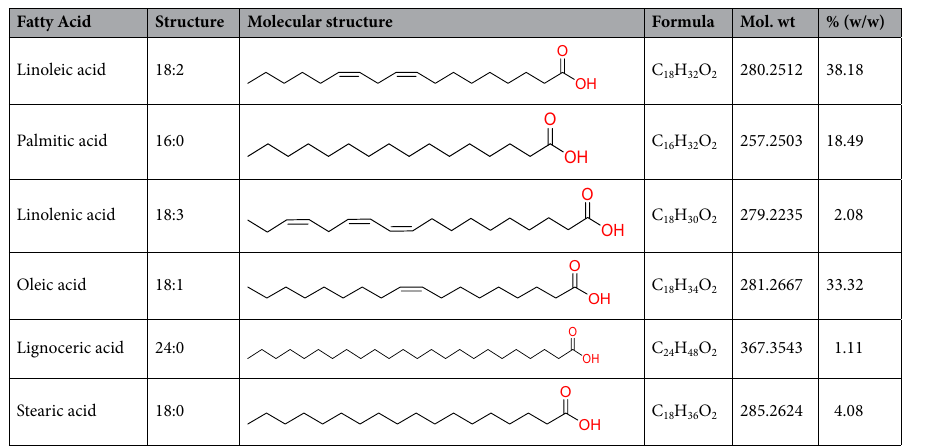
Table 2. Free fatty acid composition of Roselle biodiesel.